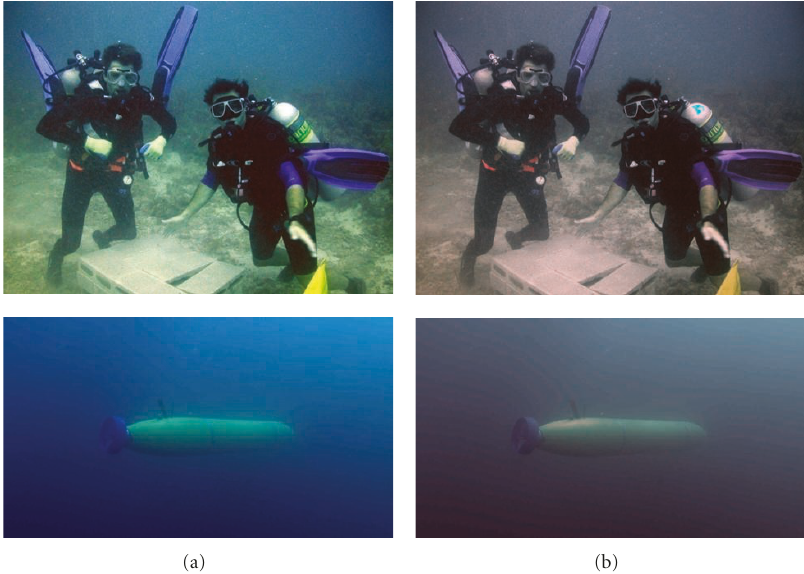
Figure 9: Original image (a), corrected by Petit et al.’ algorithm (b). Image courtesy of Petit et al.